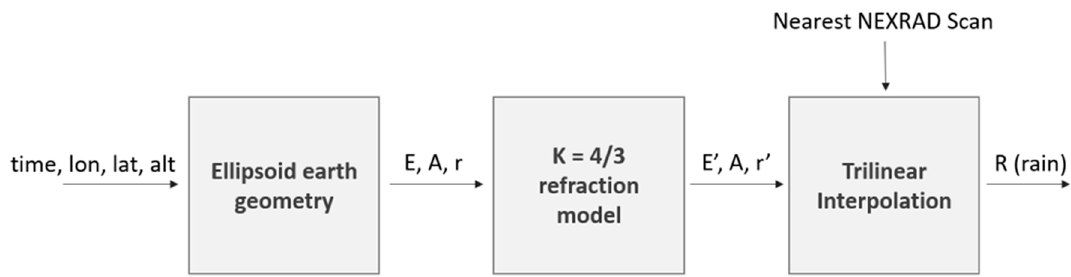
Figure A2. NEXRAD Spatial Interpolator Block Diagram.